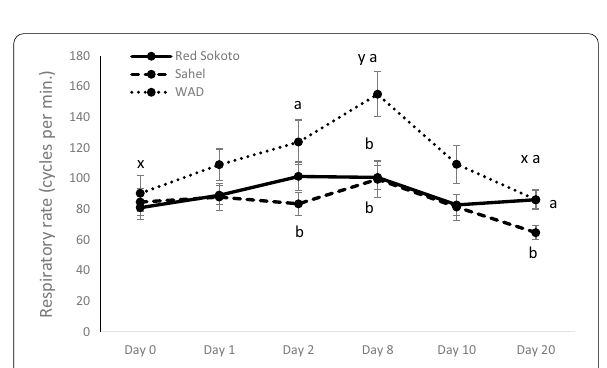
Fig. 2 Changes in afternoon respiratory rate in different breeds of neonatal Nigerian goats from birth to Day 20. Values with a , b and x , y indicate significantly different ( P < 0.05) between different breeds and ages,